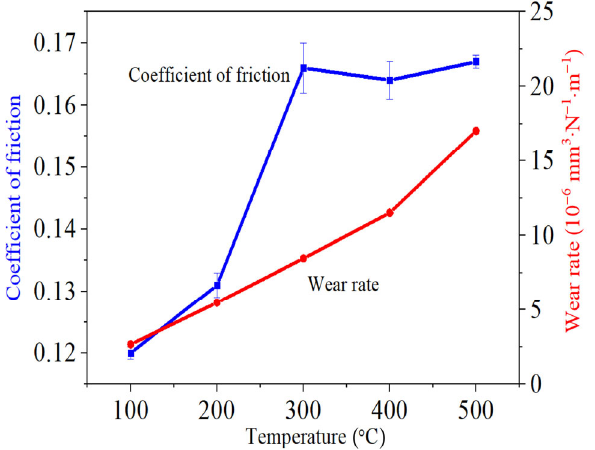
Fig. 8 COF and wear rate of LAS and C f /LAS composites at different temperature.